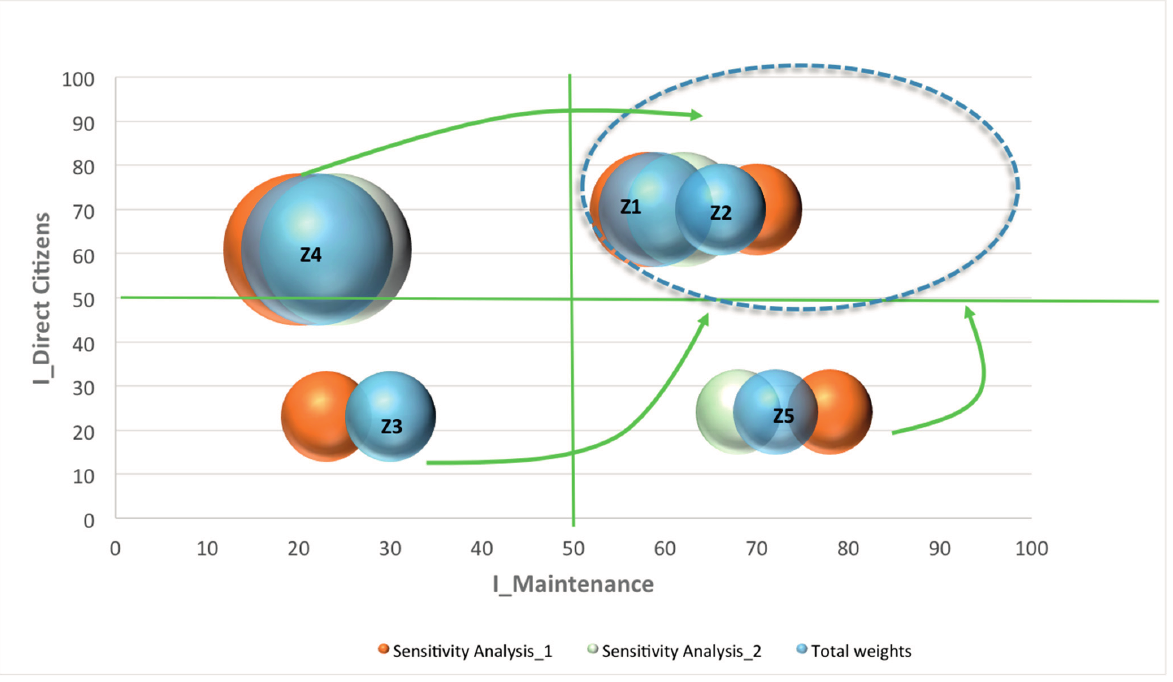
Figure 5. Visual classification of territory (Zones) by main categories of ESS in the Serra d’Espadà Natural